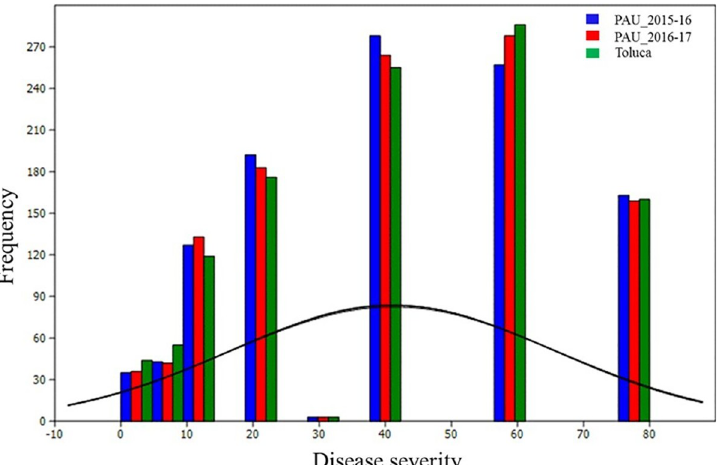
Fig 1. Graph showing the frequency distribution of Mexican bread wheat landraces for Yellow Rust (YR) disease severity score in India (PAU: Punjab Agriculture University, 2015–16 and 2016–17 seasons) and Mexico (Toluca: 2016–17 season). Disease severity score plotted on X-axis and frequency on Y-axis, respectively.